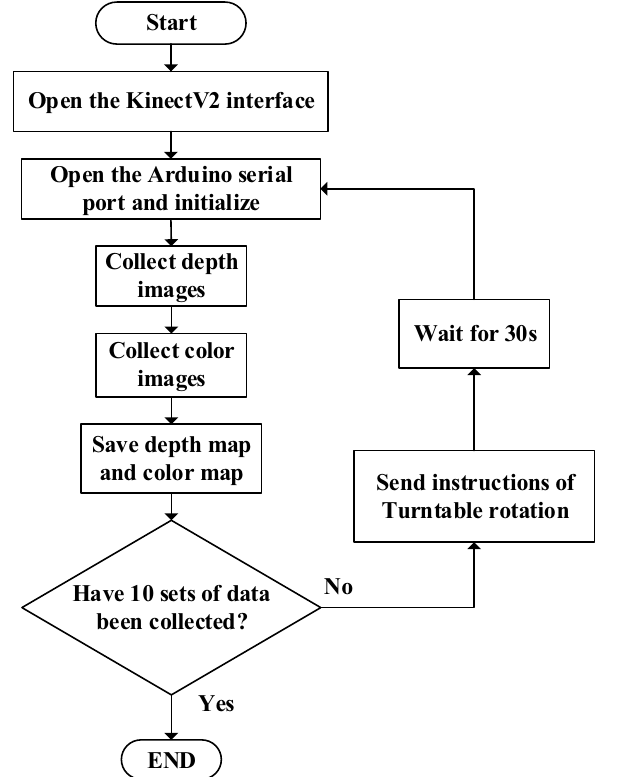
Figure 3. Flow chart of data collection